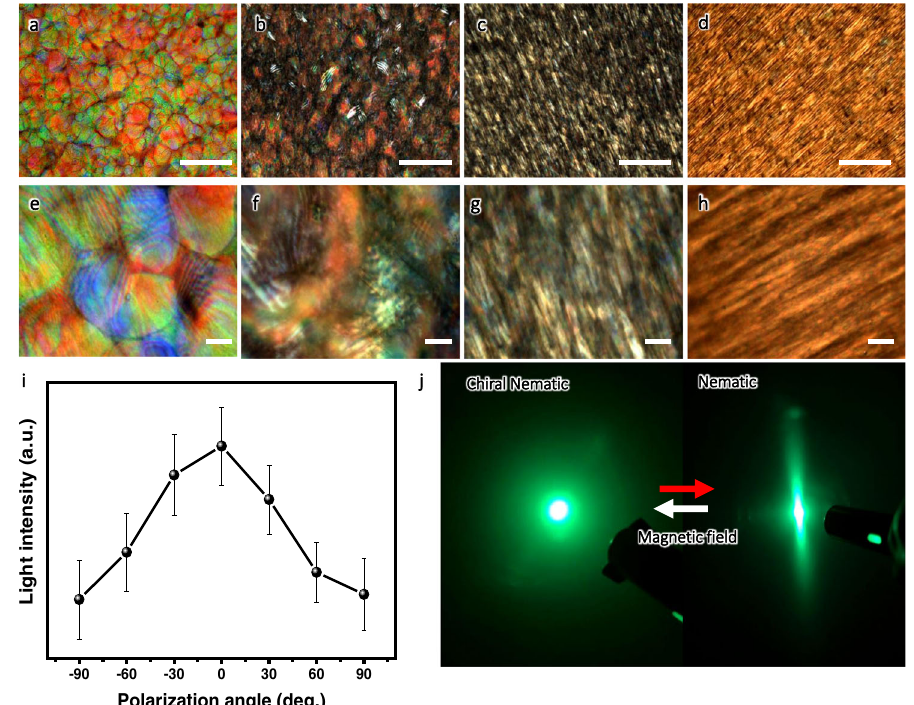
Fig. 3 | Transformation of optical images and properties under magnetic fi eld. POM images at different magni fi cations of a , e bCNC fi lms, b , f bCNC_MNP1, c , g bCNC_MNP2, and d , h bCNC_MNP3 fi lms were taken with crossed polarizers. Scale bars are a – d 200 μ m and e – h 20 μ m, respectively. i The azimuthal